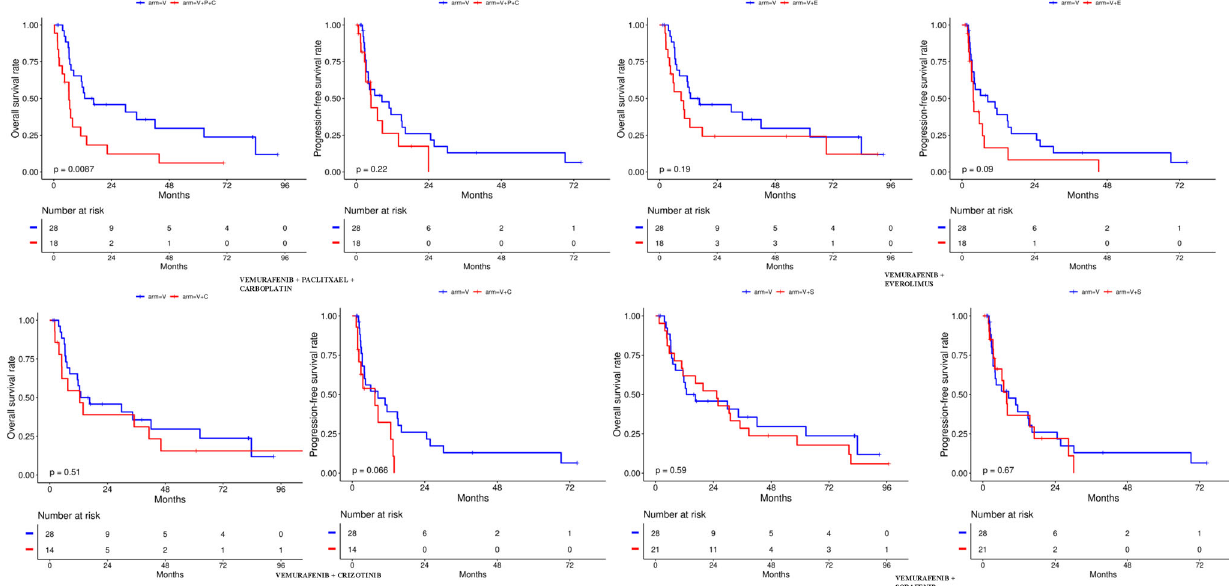
Fig. 1 Best responses strati fi ed by histology and duration of responses in the VEM-PLUS study. GBM, glioblastoma multiforme, NET neuroendocrine tumor, NSCLC non-small cell lung cancer, SCC squamous cell carcinoma, V vemurafenib. V + P + C vemurafenib + paclitaxel + carboplatin. V + E vemurafenib + everolimus. V + C vemurafenib +